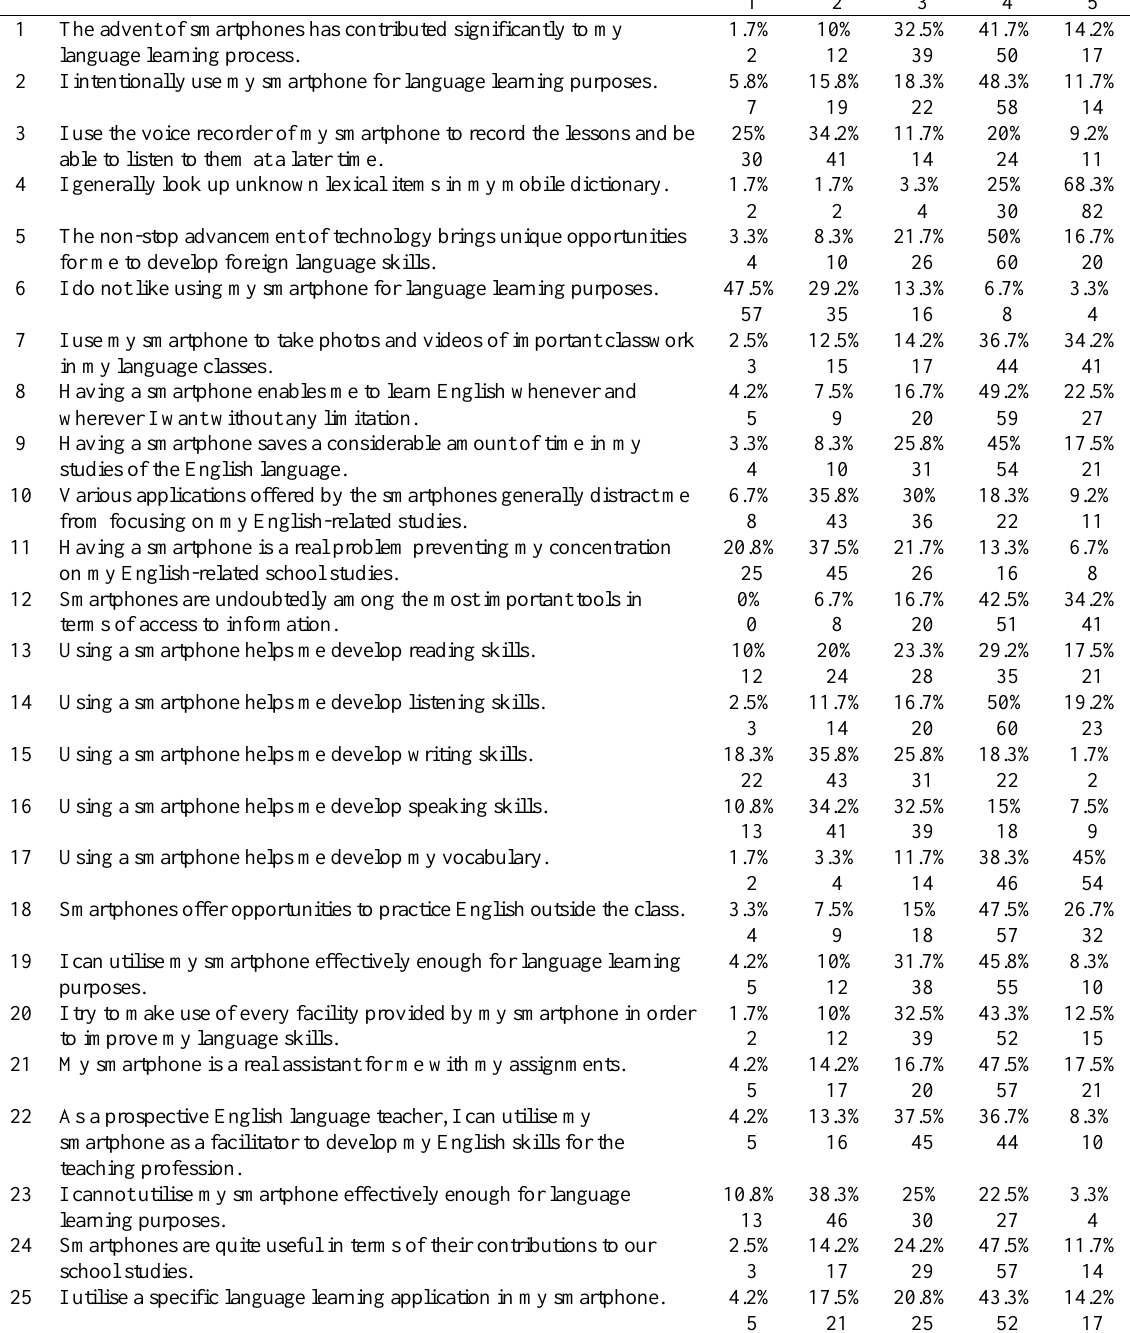
Table 1 Frequency analysis of the participants’ responses to the items in the